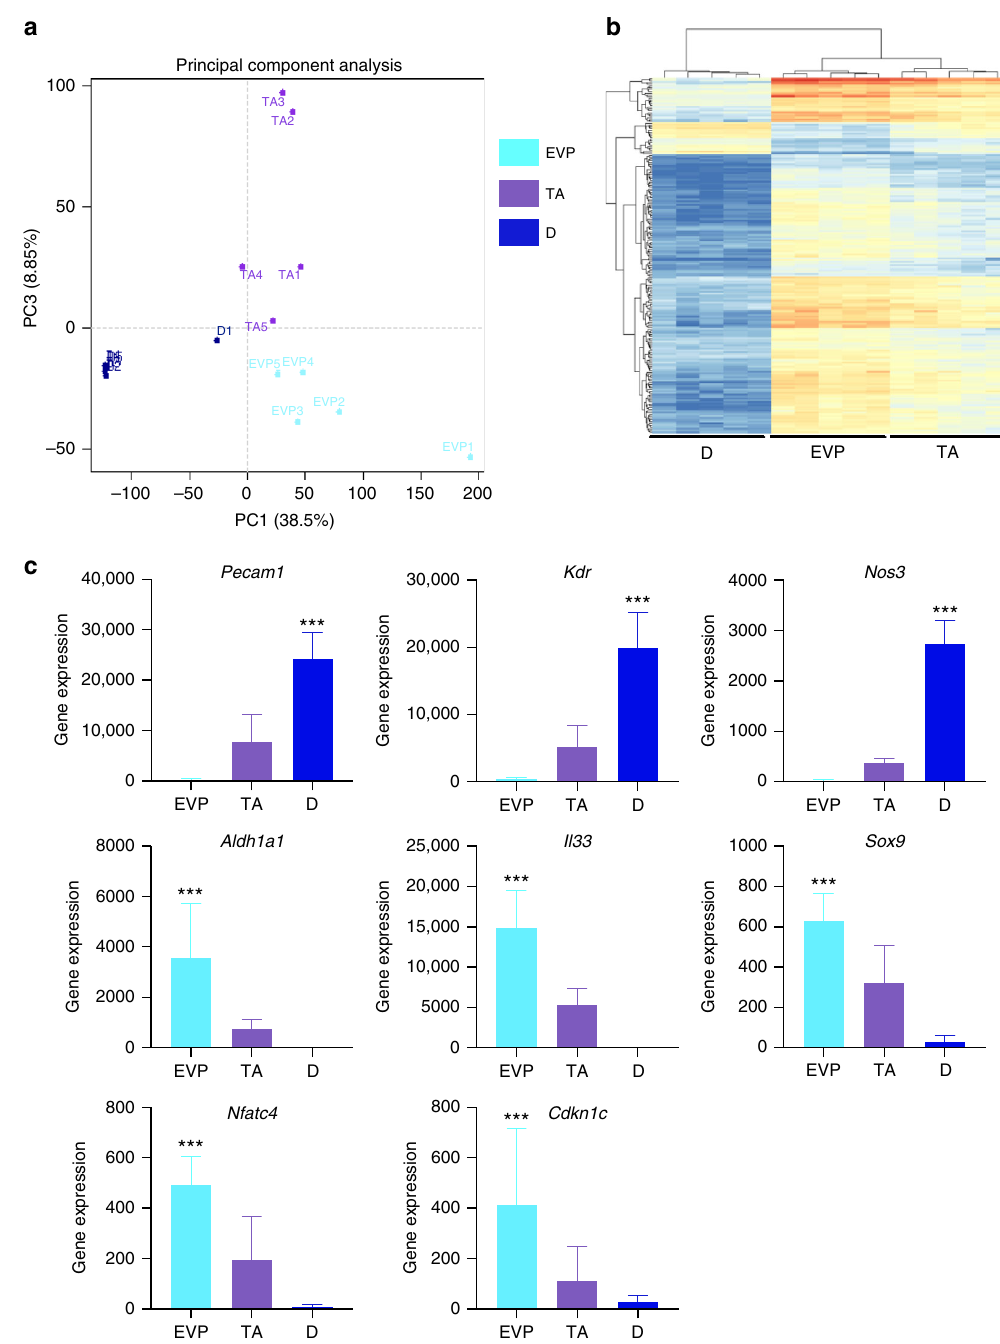
Fig. 6 Endothelial hierarchy RNA sequencing and gene expression analysis. a , b Principal component analysis and hierarchical clustering demonstrating the distinct clustering of each population segregated from each other ( n = 5). c Differentially expressed genes (* p < 0.05 after multiple testing correction) were identi fi ed between EVP and D populations. Differentiated endothelial markers Pecam , Kdr , and Nos3 were all signi fi cantly upregulated in D compared to EVP (*** p < 0.001 vs EVP). Results presented as mean ± SEM. EVP endovascular progenitor, D de fi nitive